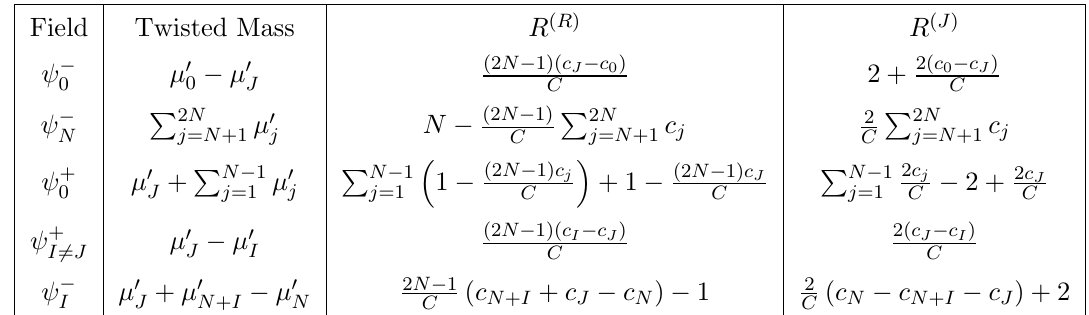
Table 2 . The spectrum of the charged sector around the (cid:12)rst vacuum in equation (4.23). Field